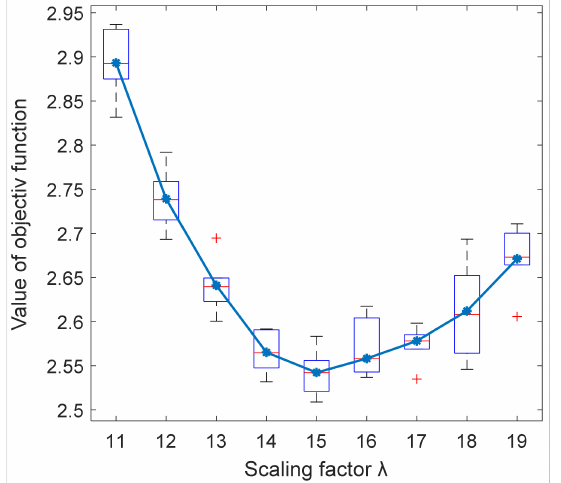
Figure 7. The boxplot of the scaling factor λ .